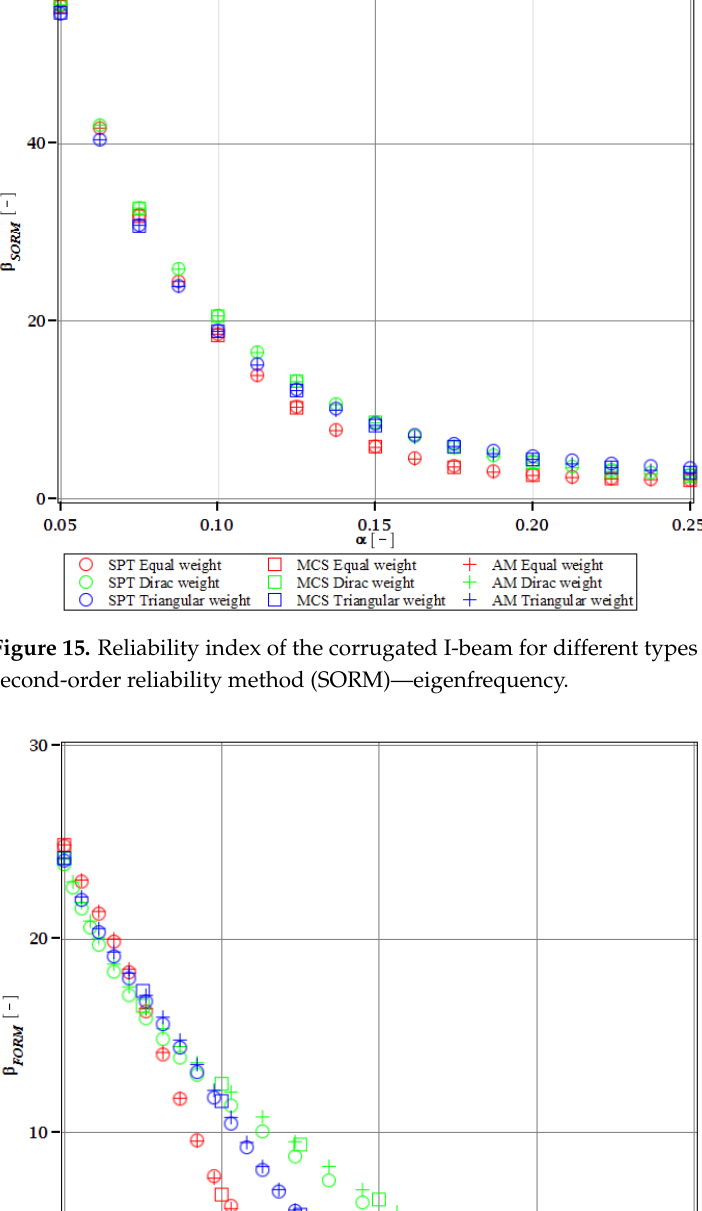
Figure 14. Reliability index of the corrugated I-beam for different types of weights according to the second-order reliability method (SORM) — shear.